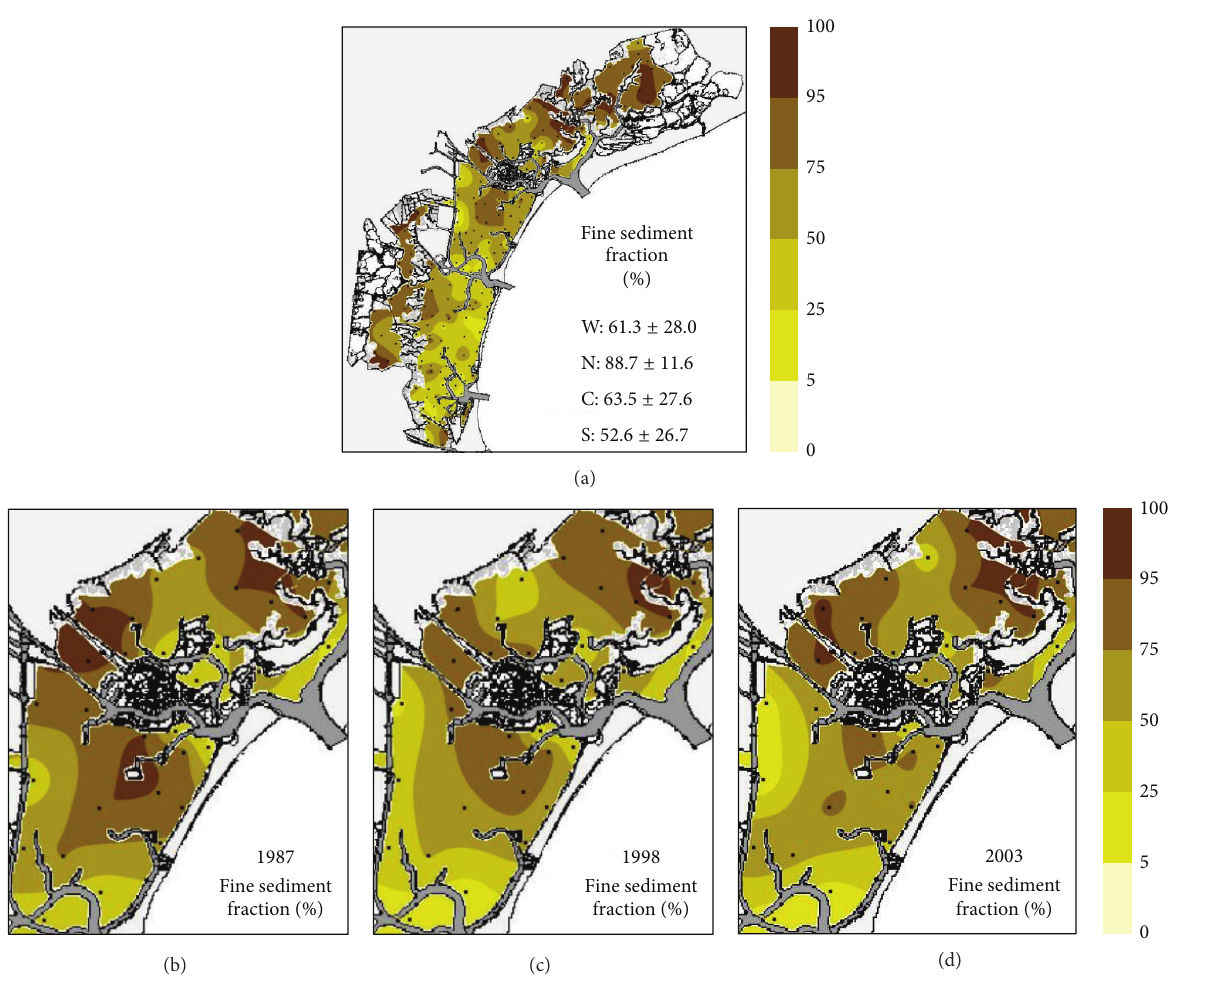
Figure 3: Spatial distribution of fine sediments (fraction < 63 𝜇 m) in 2003 (a). Mean values and standard deviations shown on map for whole lagoon (W) and northern (N), central (C) and southern (S) basins. Other maps indicate distributions in 1987 (b), 1998 (c), and 2003 (d) in central